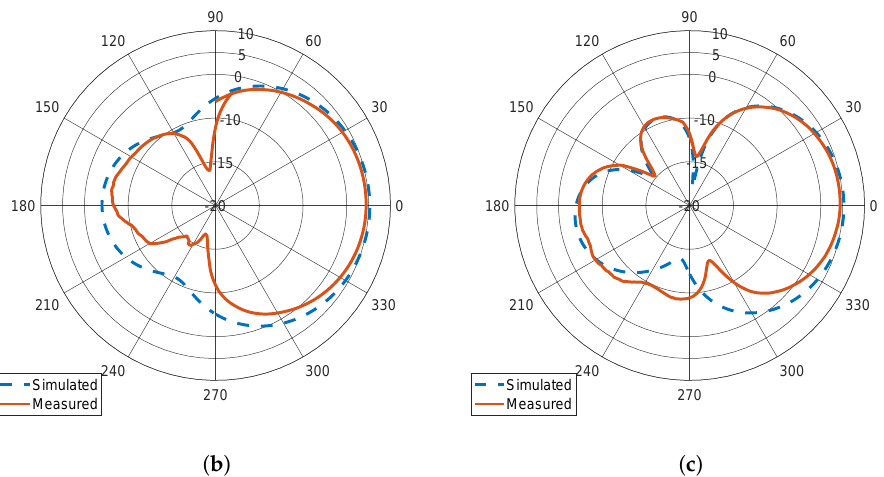
Figure 10. Measured and simulated ( a ) S 11 parameter and radiation pattern in: ( b ) the azimuth ( c ) elevation planes, respectively, for the balanced microstrip slotted patch antenna (including the